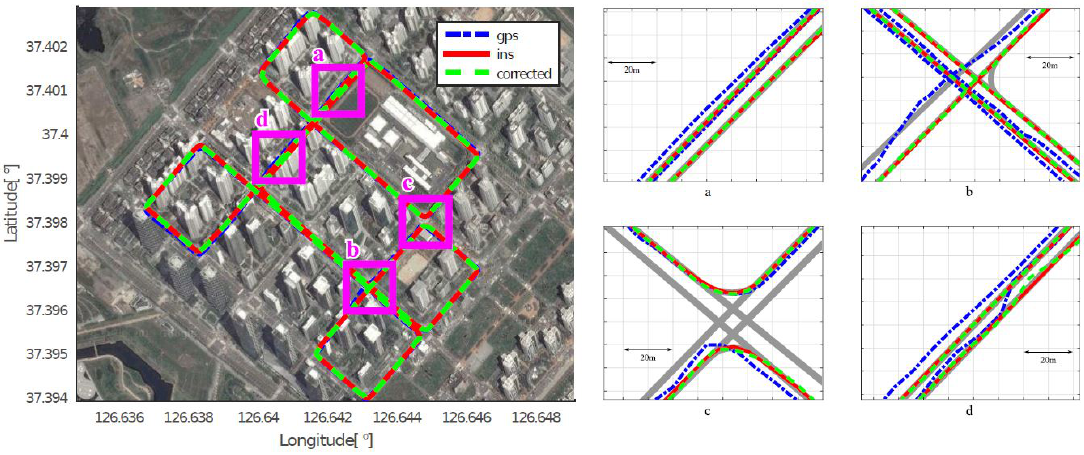
Figure 11. Experimental results for Course 4.